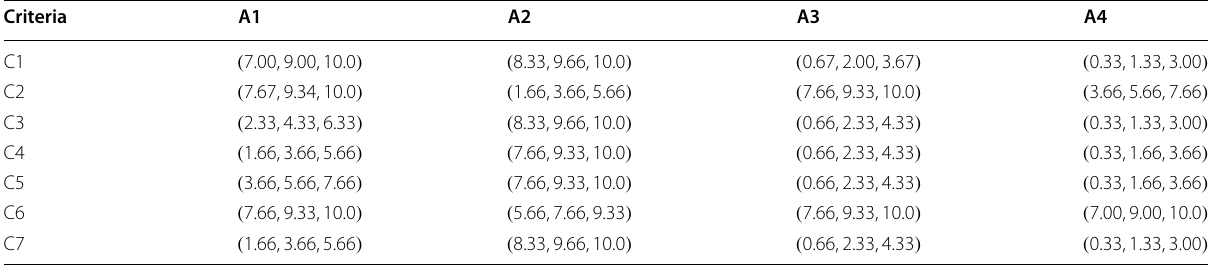
Table 9 Fuzzy decision matrix